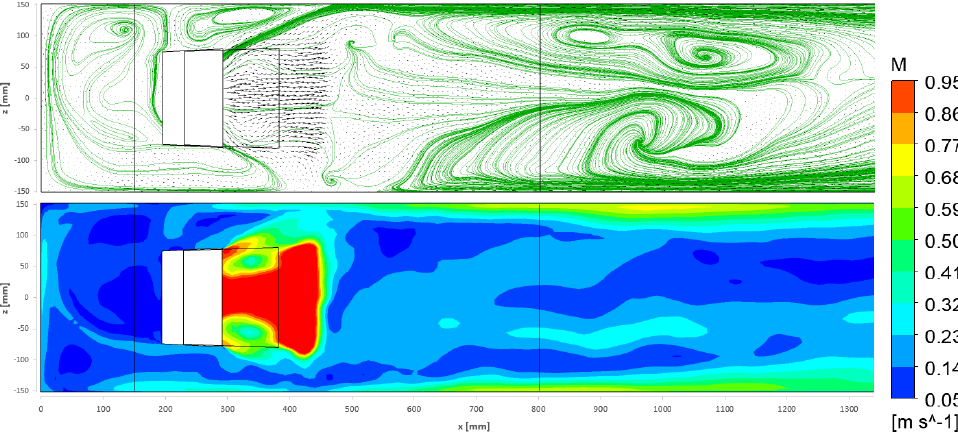
Figure 29. Finite volume method (SAS model), vector lines ( top ) and the magnitude of time-averaged 2D velocity ( bottom ) in horizontal plane ( y = 170mm ) .